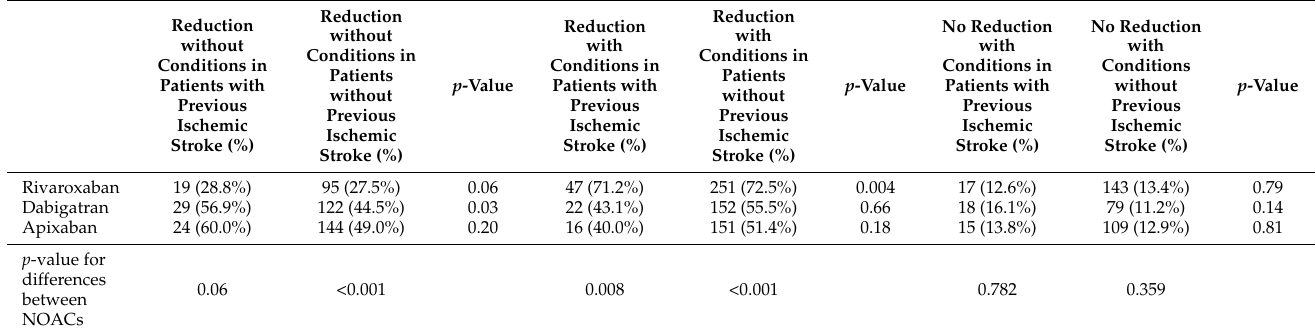
Table 6. Reduced doses of NOACs in patients with and without previous ischemic